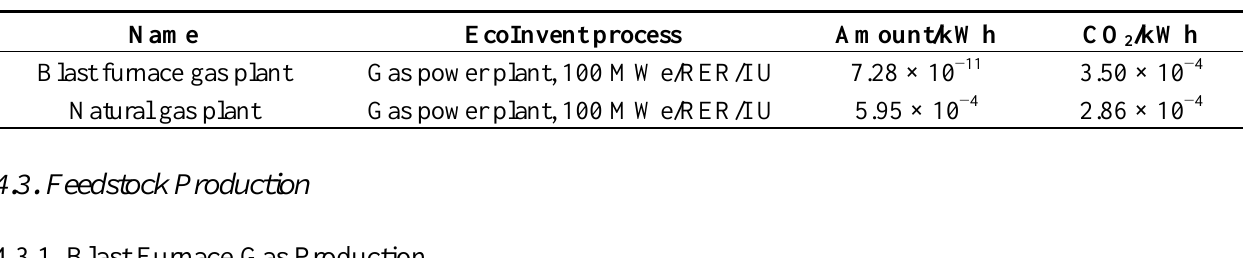
Table 1. EcoInvent assumptions on different power plant infrastructures